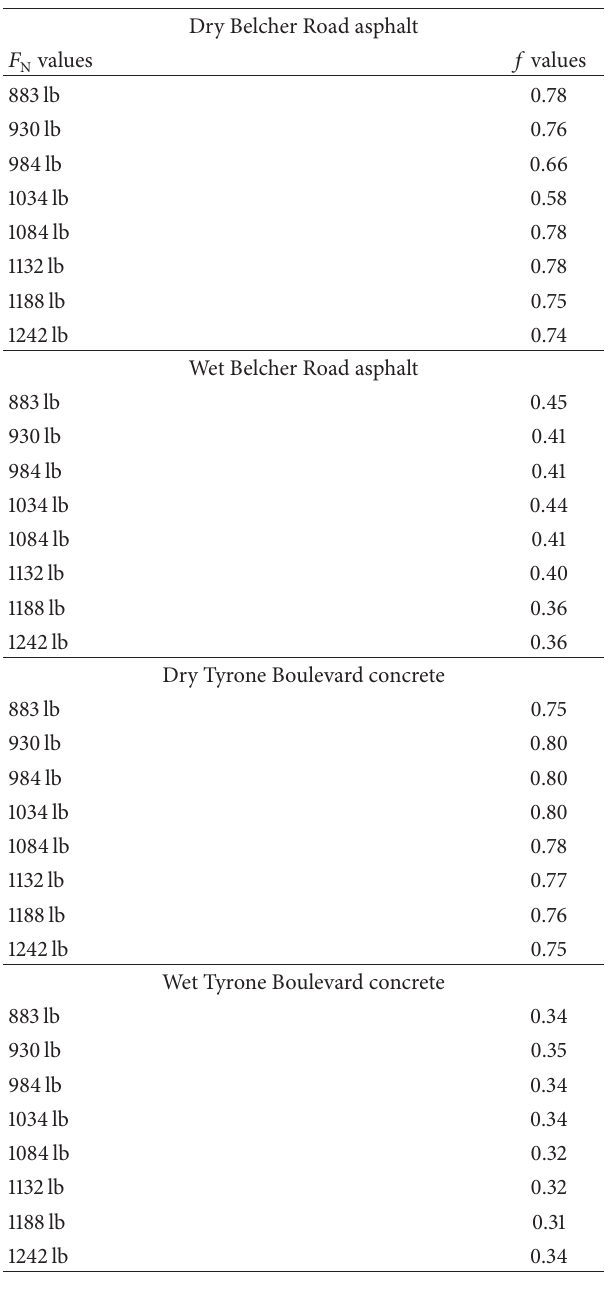
Table 7: Calculated 𝑓 values for all locked-wheel